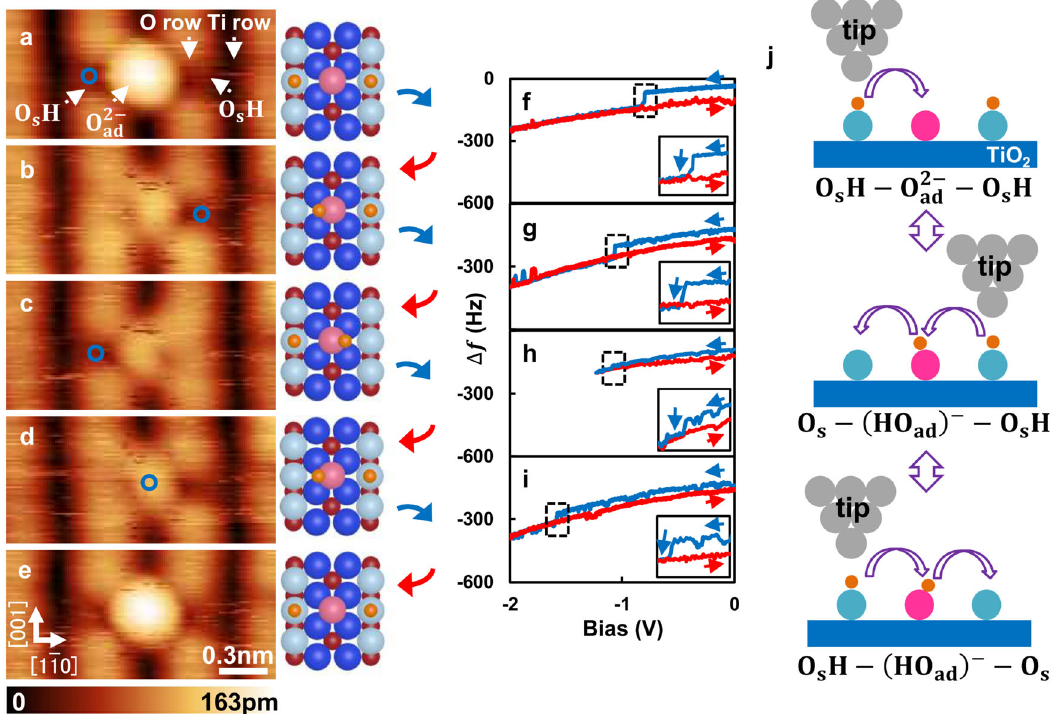
Fig. 1 Control of O s H − O ad 2 − O s H reaction by KPFS manipulation. a AFM image of O s H − O ad 2 − − O s H on rutile TiO 2 surface. b – e Consecutive AFM images of three adsorption species in the reversible manipulation sequence. Imaging parameters for a – e : constant Δ f mode, V bias = 0 V and 1.0 × 2.0 nm 2 . The schematic of the fi gure, O s (white balls): rows of twofold-coordinated bridge oxygen atoms; (blue balls): in plane threefold coordinated oxygen atoms; Ti (red balls at the middle of the oxygen row): rows of fi vefold-coordinated Ti atoms; H (orange) hydrogen and O ad (pink) adsorbed single-oxygen adatom. f – i Results of KPFS applied to images between a – b , b – c , c – d , and d – e . The feedback loop was switched off during the measurements, and the sample bias was ramped from zero to a certain negative voltage and then ramped back to zero. The blue and red lines show the spectra KPFS obtained by forward and backward directions, respectively. The tip position is indicated by a blue circle in the images of a – d . The insets in f – i show enlarged KPFS curves within dashed boxes placed around the regions of frequency jumps: between − 1.0 V and − 0.8 V ( f ), − 1.1 V and − 1.0 V ( g ), − 1.2 V and − 0.9 V ( h ) and − 1.6 V and − 1.5 V ( i ). j Schematic of O s H − O ad 2 − − O s H water reaction controlled by KPFS manipulation, including O s H − O ad 2 − − O s H, O s − (O ad H) − − O s H and O s H − (O ad H) − − O s